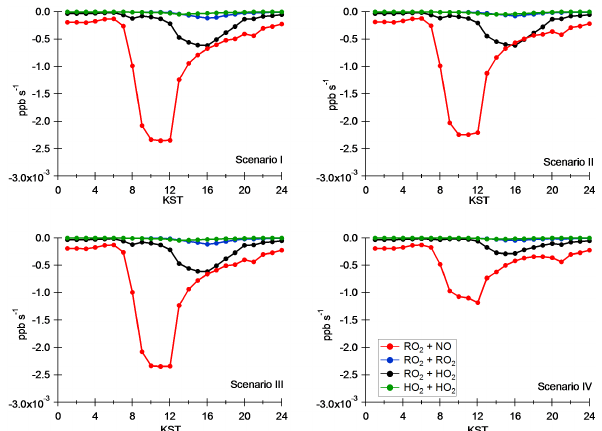
Figure 4. The temporal variations of radical recycling (red) and de- struction (blue, black, and green) rates calculated using the UWCM box model for different model